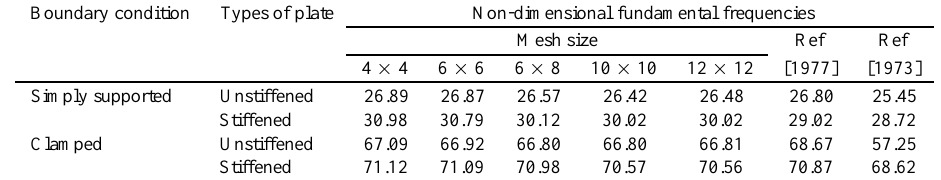
Table 5 Convergence and validation of non-dimensional fundamental frequencies of a SSSS and CCCC unstiffened / stiffened square plates with cutout. g/a = 0.5, a/b = 1, b/h = 100, γ = 10